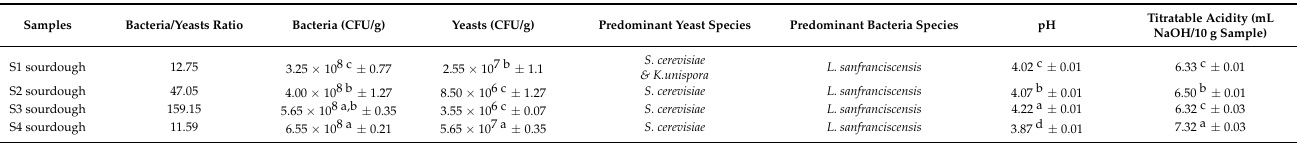
Table 2. Microbiological characterization, pH value, titratable acidity of 8 months refreshed sourdoughs used to pro- duce bread.